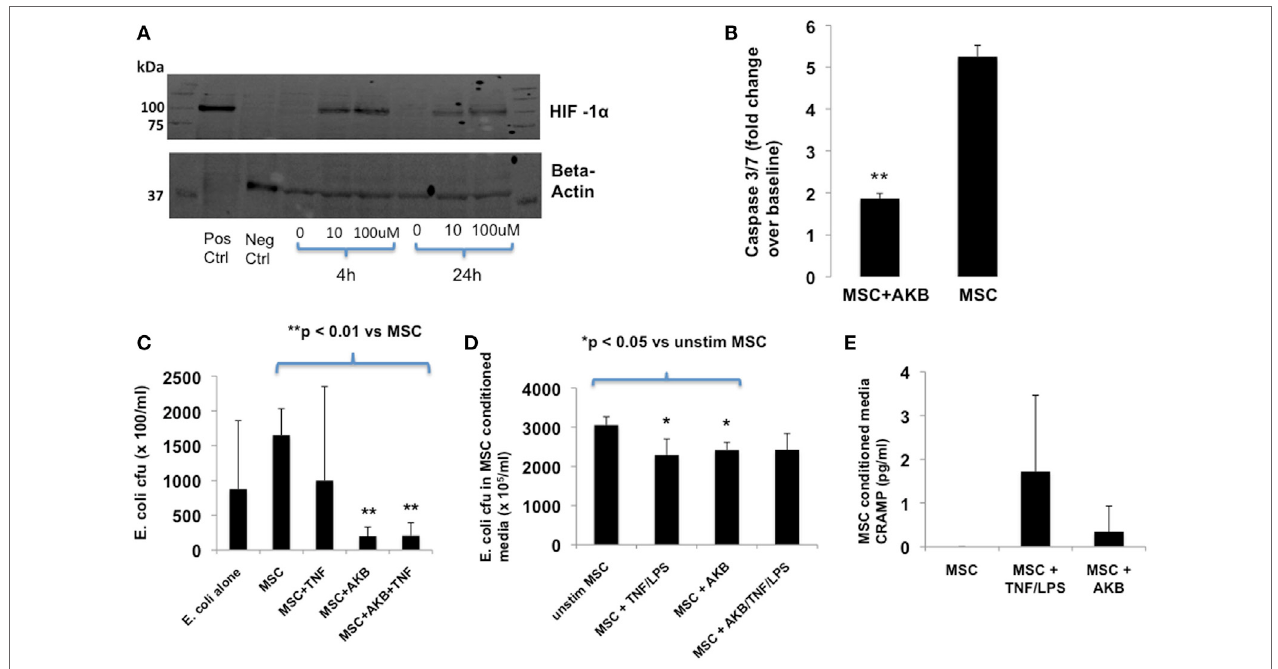
figUre 1 | AKB-4924 stabilizes hypoxia-inducible factor 1 α (HIF-1 α ) in mesenchymal stem cells (MSCs) and improves MSC survival and bacterial clearance under in vitro conditions. Use of AKB-4924 at both 10 and 100 µM resulted in detectable amounts of HIF-1 α protein in MSCs after 4 and 24 h of incubation (a) . AKB-4924 significantly reduced caspase 3/7 activity in MSCs exposed to TNF- α and cycloheximide for 5 h [ (B) , ** p < 0.01 for MSC + AKB vs MSC, n = 6 per group]. MSCs pre-stimulated with AKB-4924 exhibited enhanced bacterial clearance at 6 h [ (c) , ** p < 0.01 when compared with MSC group, n = 4 per group] that may be partially due to a soluble antimicrobial factor [ (D) , * p < 0.05 compared with unstim group, n = 4 per group]. Cathelicidin-related antimicrobial protein (CRAMP) was not significantly increased in the conditioned media of MSCs pre-treated with AKB-4924 when compared with unstimulated MSCs [ (e) , n = 3 per